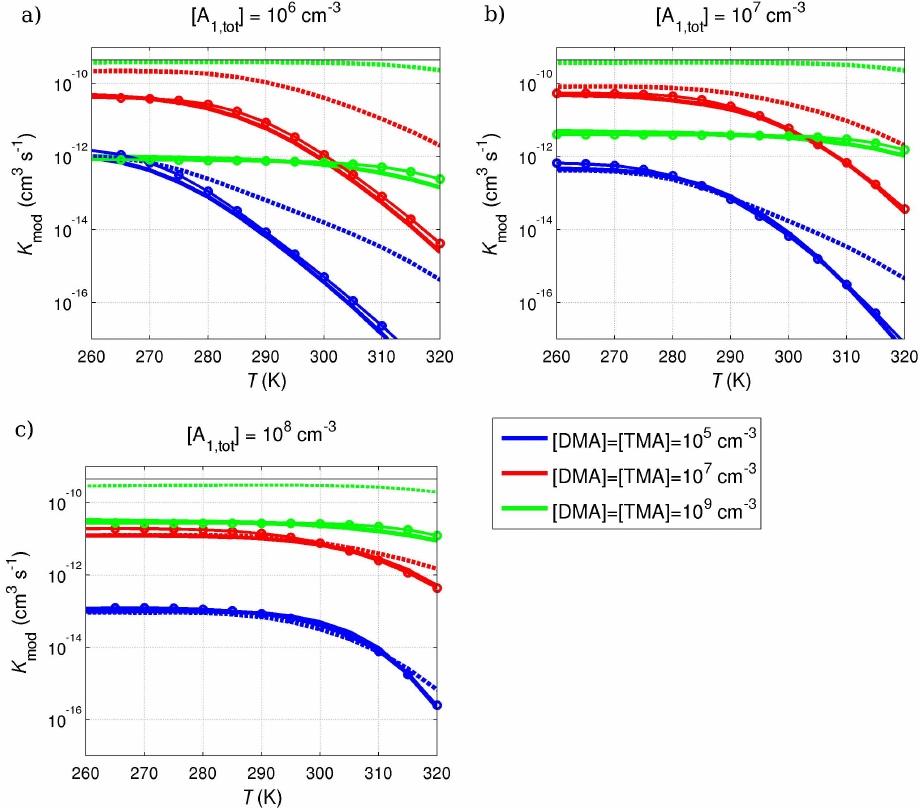
Fig. 5. Modelled coefficients K 22 , the ratio of J 22 and squared total sulphuric acid monomer concentration, as a function of temperature under DMA to TMA ratio 1 : 1 (concentrations shown in the legend), when the total sulphuric acid monomer concentration [A 1 , tot ] equals to with circles to K A2D1T1 . The black line shows the collision rate of all H 2 SO 4 monomers.